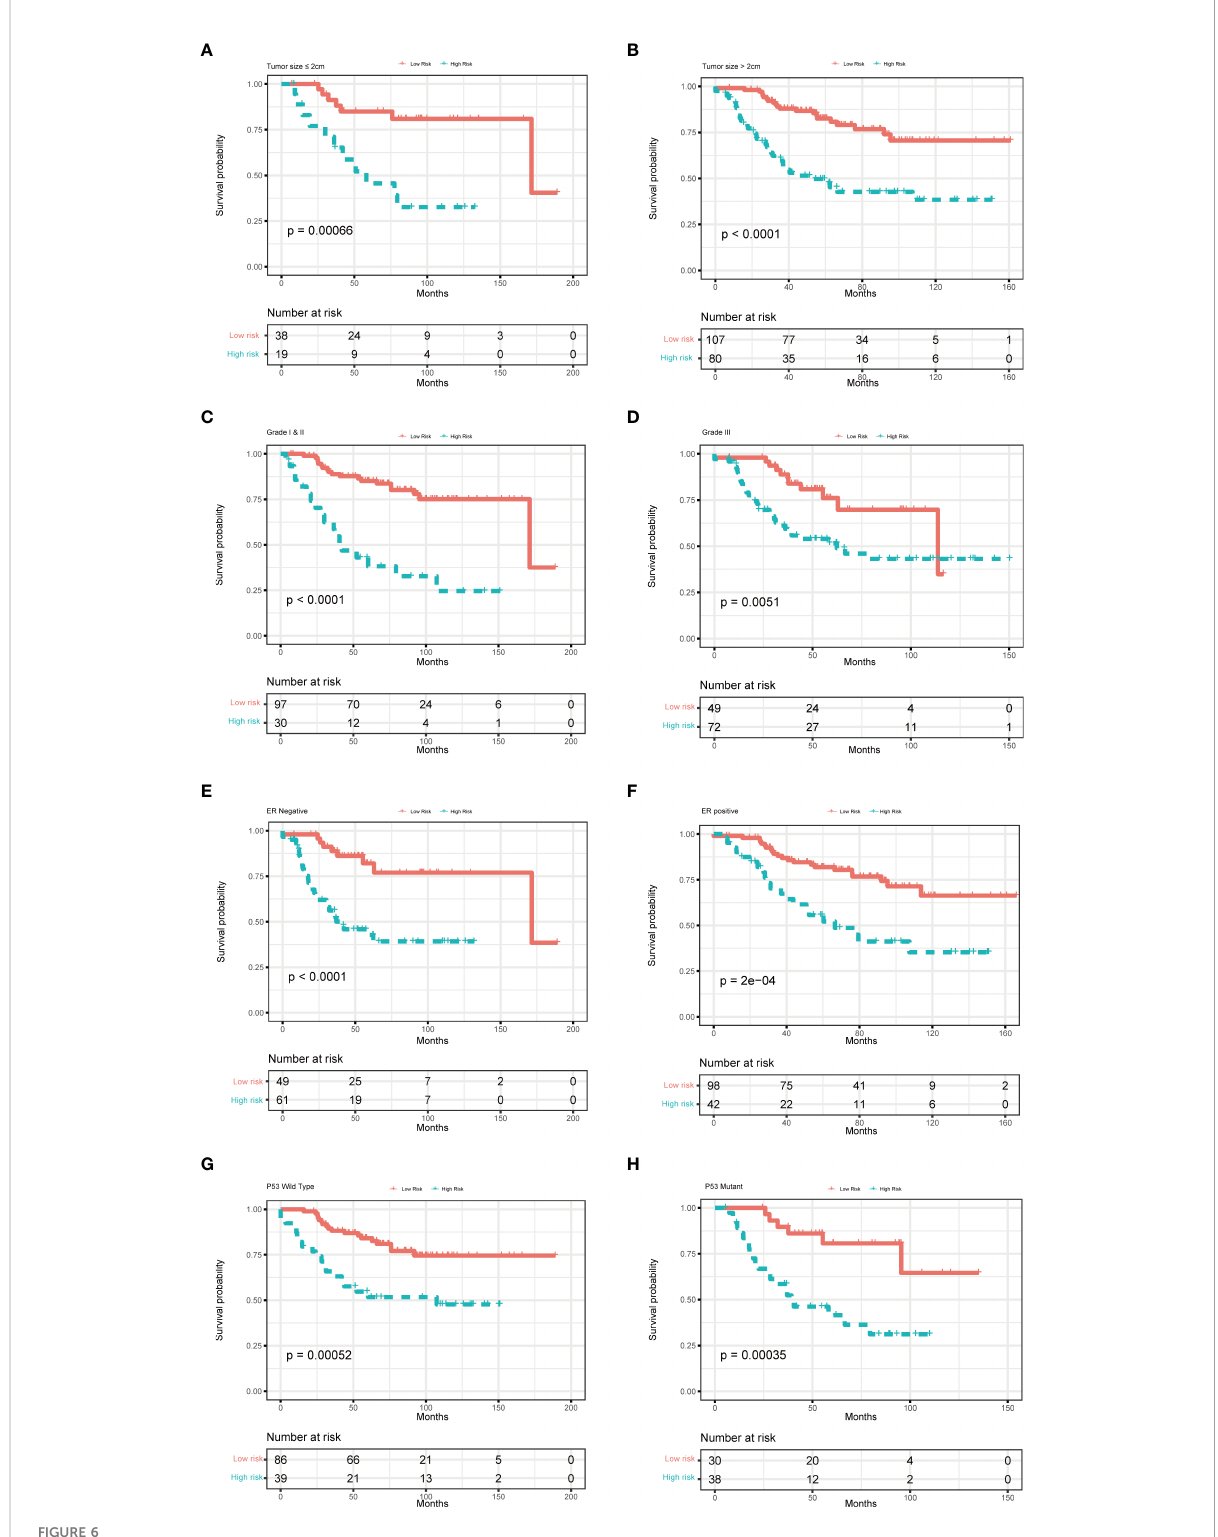
FIGURE 6 Multivariate Cox analysis for patients according to the predictive model strati fi ed by clinicopathological risk factors. (A, B) tumor size, (C, D) tumor grade, (E, F) ER status, and (G, H) P53